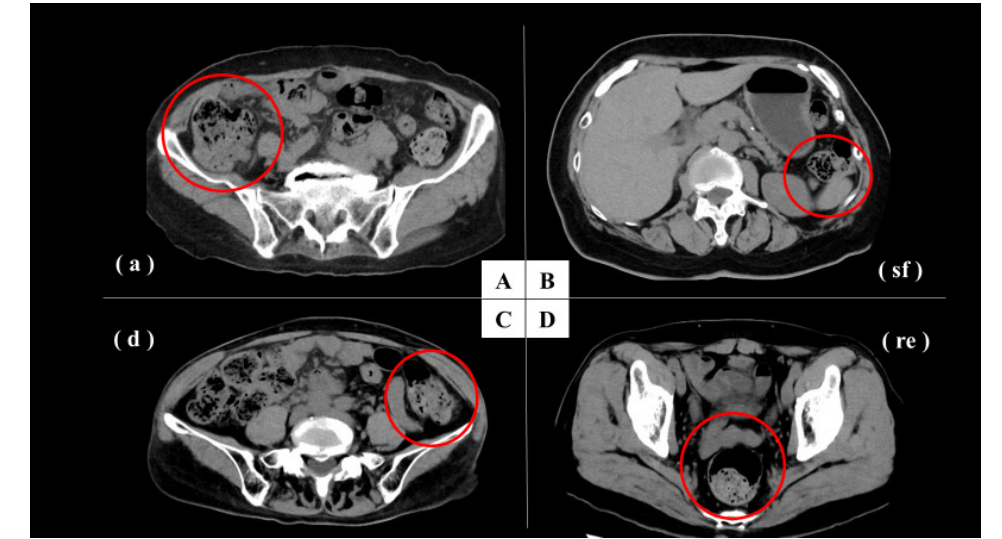
Figure 2. Representative cases. A : CT image was used to rate the stool volume as 4 and the gas volume as 2 (red circle). ( a ), Ascending colon. B : CT image was used to rate the stool volume as 1 and the gas volume as 2 (red circle). ( sf ), Splenic flexure. C : CT image was used to rate the stool volume as 3 and the gas volume as 2 (red circle). ( d ), Descending colon. D : CT image was used to rate the stool volume as 3 and the gas volume as 3 (red circle). ( re ), Rectum.